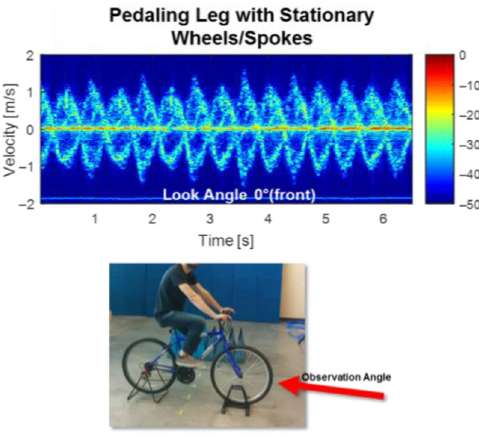
Figure 14 Micro-Doppler effect of pedaling motion